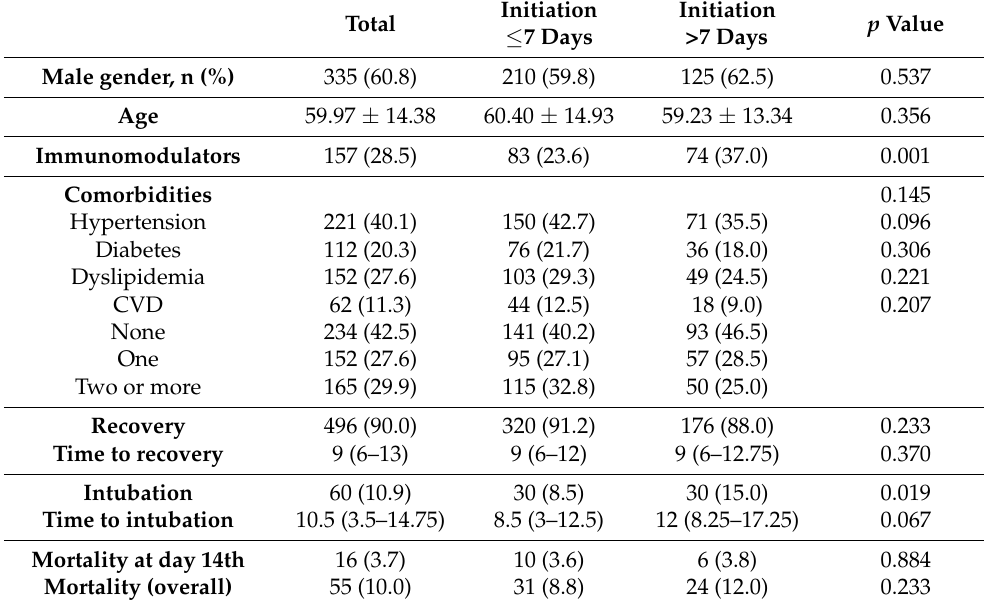
Table 1. Characteristics and clinical outcome of patients based on time of remdesivir